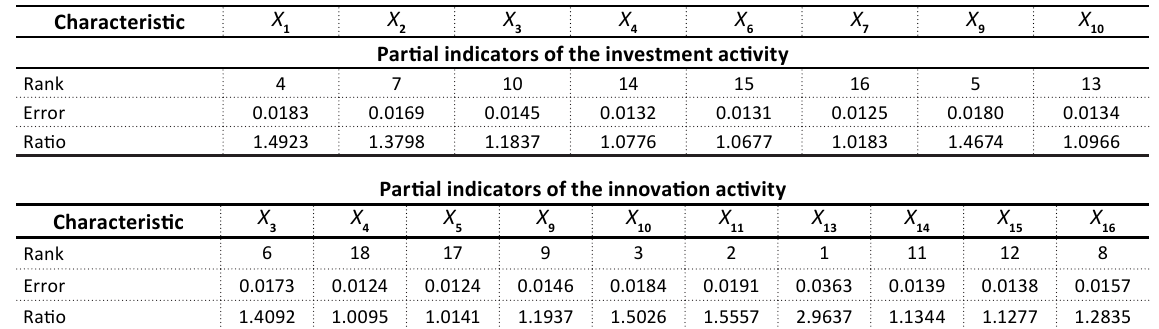
Table 6. Rank, calculation error and indicator sensitivity of the selected multilevel perceptron